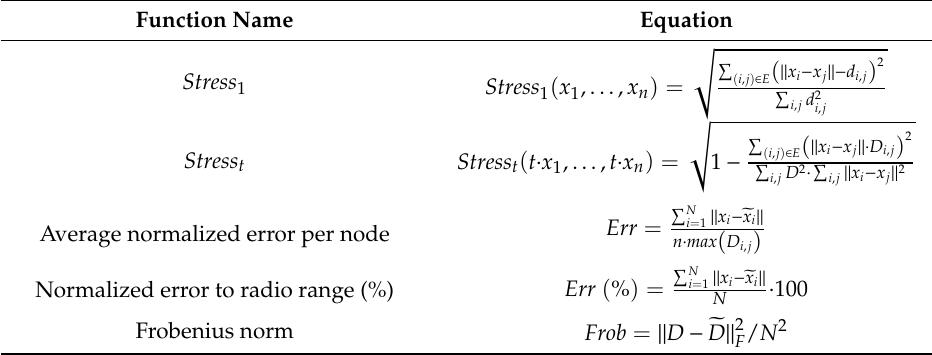
Table A1. Stress functions implemented in